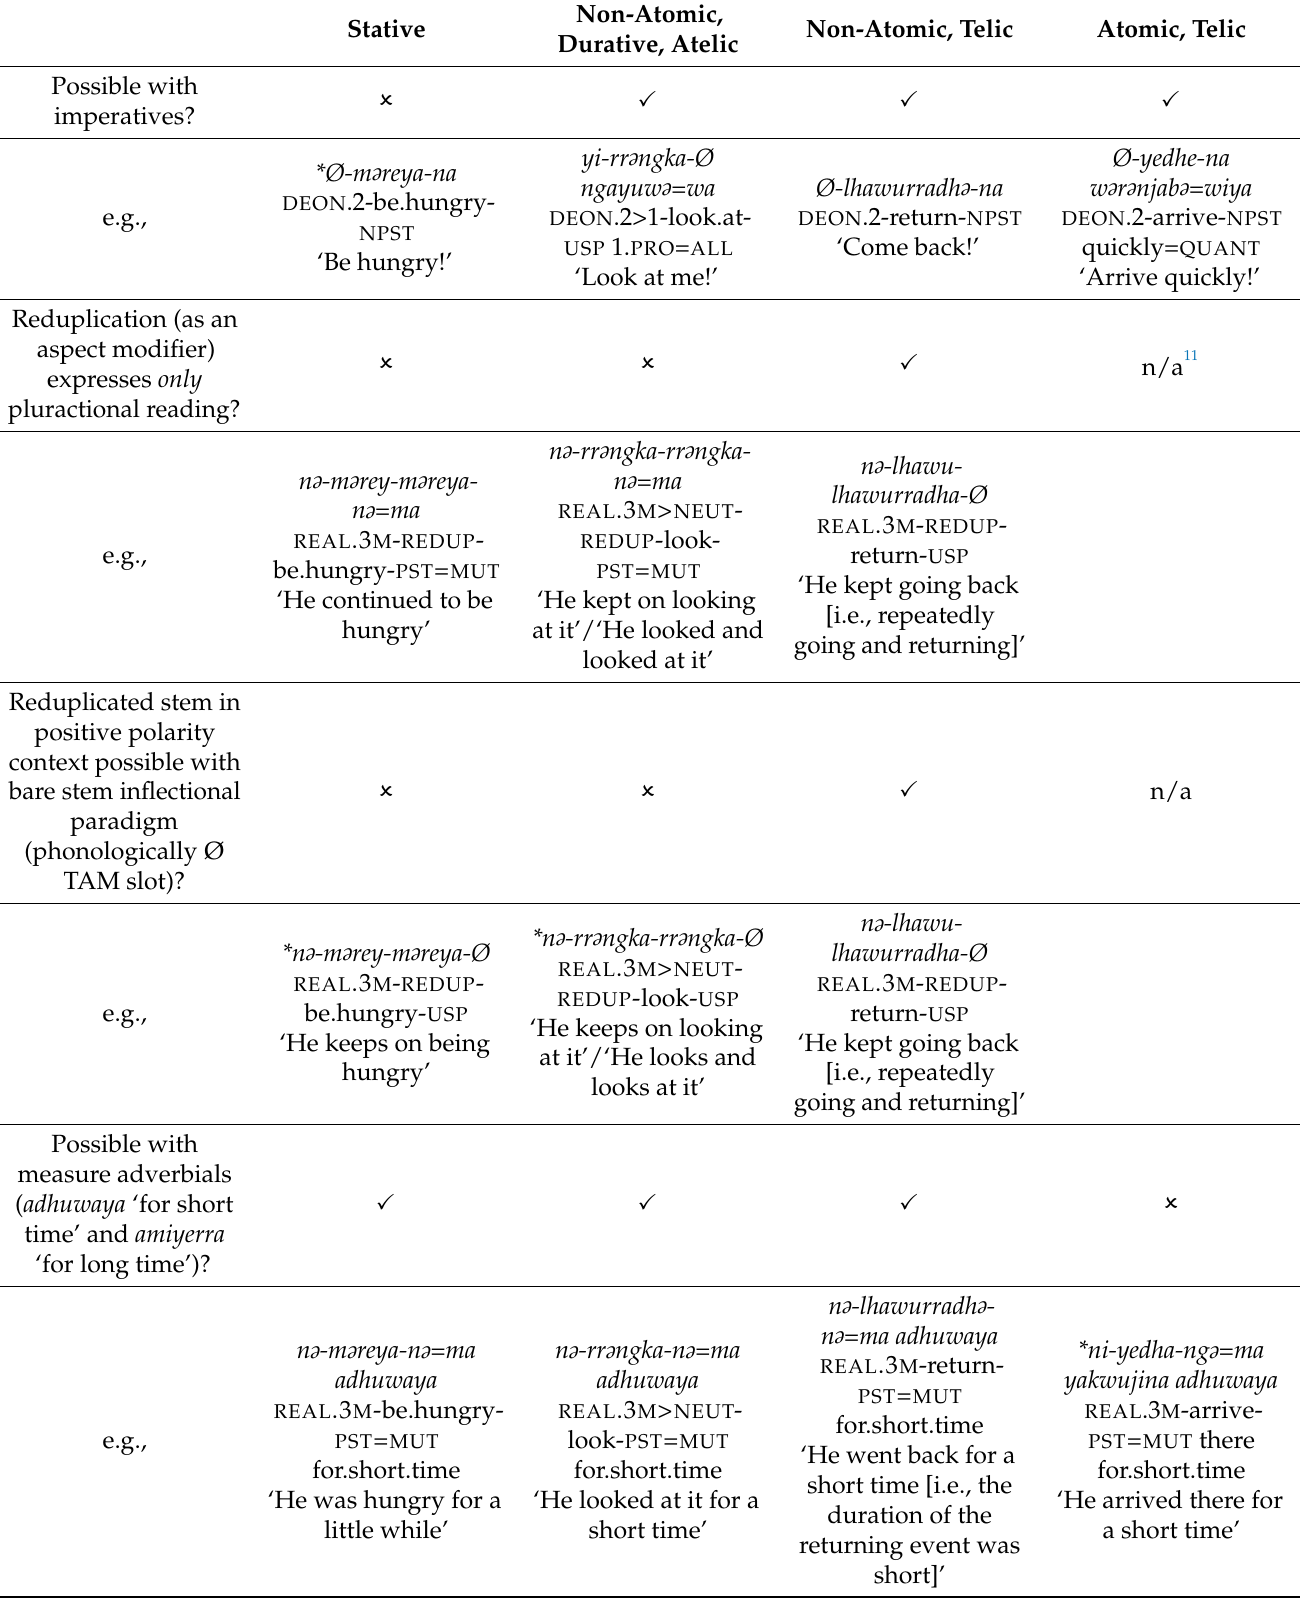
Table 4. Aktionsart properties in Anindilyakwa and variables with which to identify